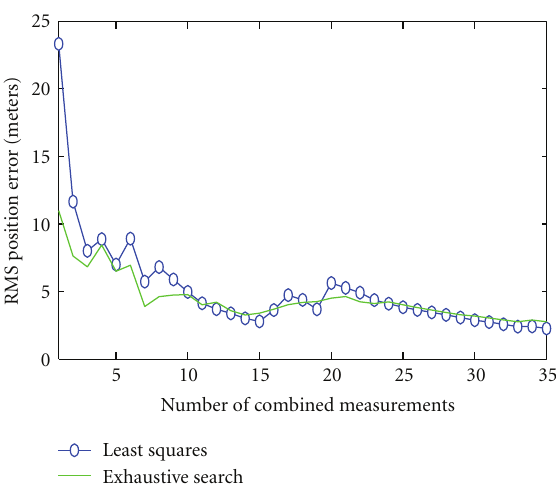
Figure 11: Localization error during March 2010 pool test.